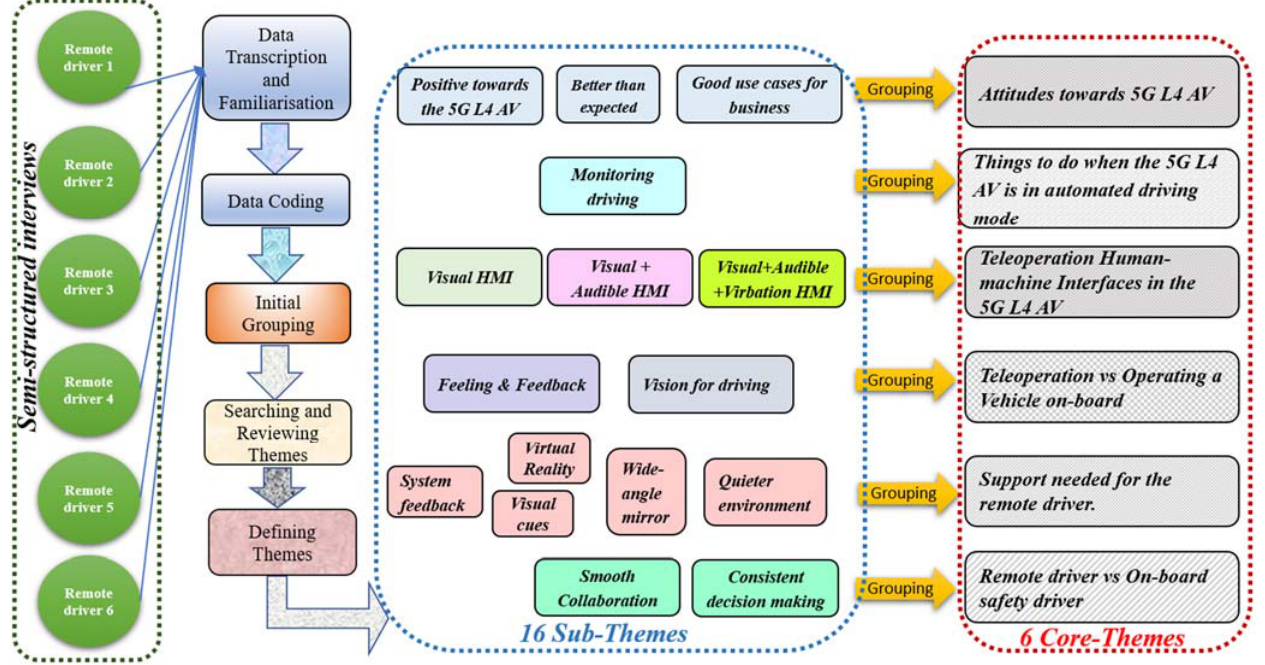
Figure 4. Illustration of thematic analysis of remote drivers’ needs and requirements towards the 5G L4 AV.